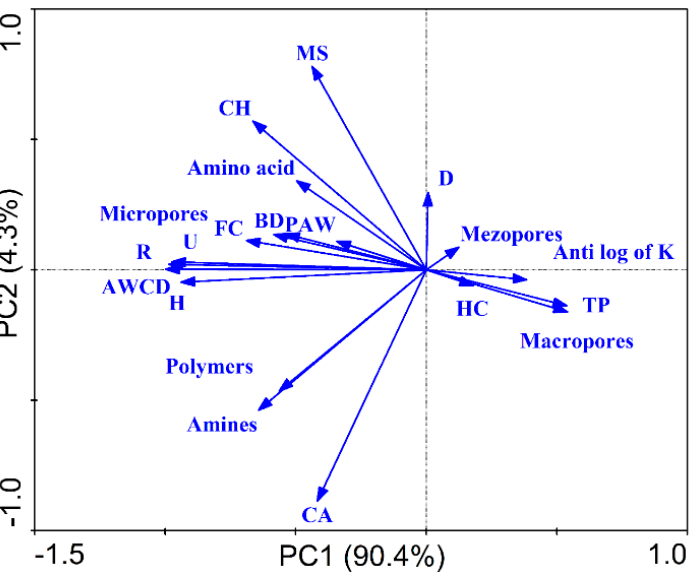
Figure 9. Pearson’s correlations for bulk density (BD), total porosity (TP), field capacity (FC), plant- available water (PAW), average well color development (AWCD), richness (R), the Shannon index (H), the Simpson index (D), the Mclntosh index (U), carbohydrates (CH), carboxylic acid (CA), miscellaneous (MS), and hydraulic conductivity (HC) under different treatments, i.e., B0N0 (without biochar or N fertilization); B0N1 (without biochar and with 160 kg · ha − 1 N); B0N2 (without biochar and with 120 kg · ha − 1 N); B1N0 (biochar 25 t · ha − 1 only); B1N1 (biochar 25 t · ha − 1 and 160 kg · ha − 1 N); and B1N2 (biochar 25 t · ha − 1 and 120 kg · ha − 1